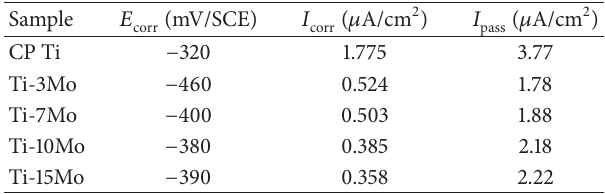
), corrosion current densities corr ) determined from the pass